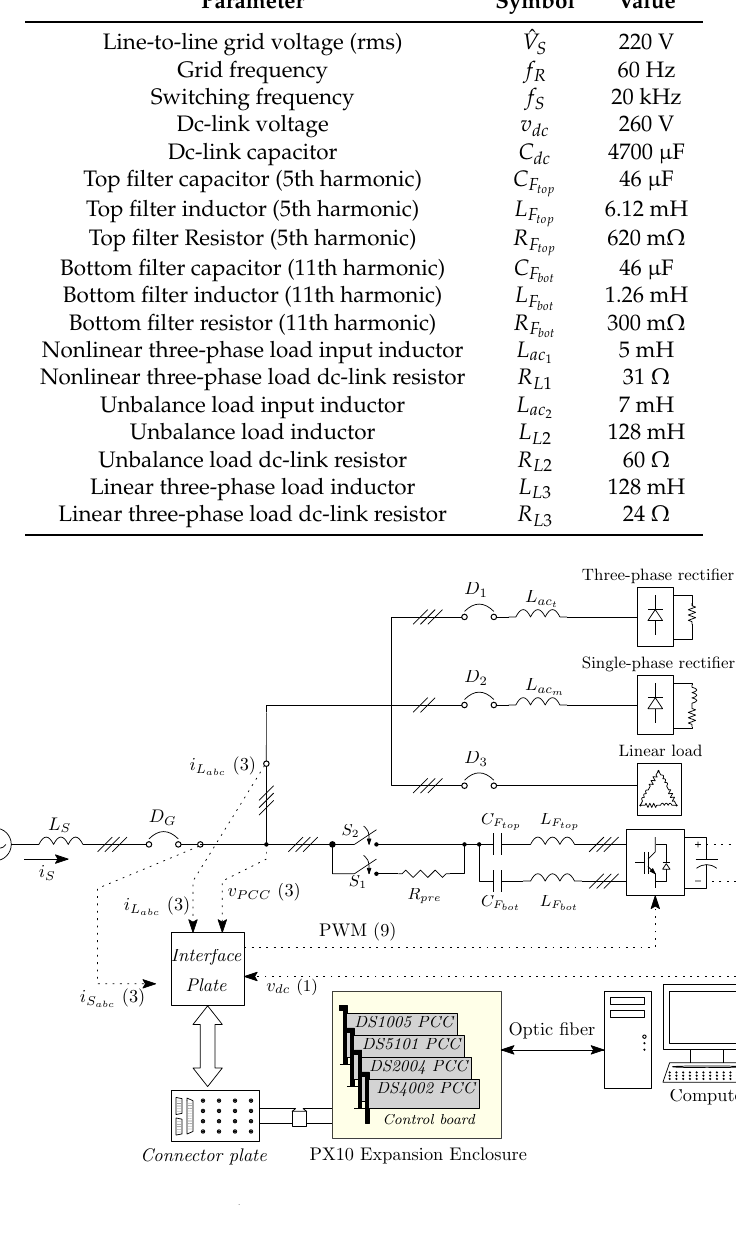
Figure 5. Single-line diagram of the experiment prototype showing the interface between the DHPF-NSI and